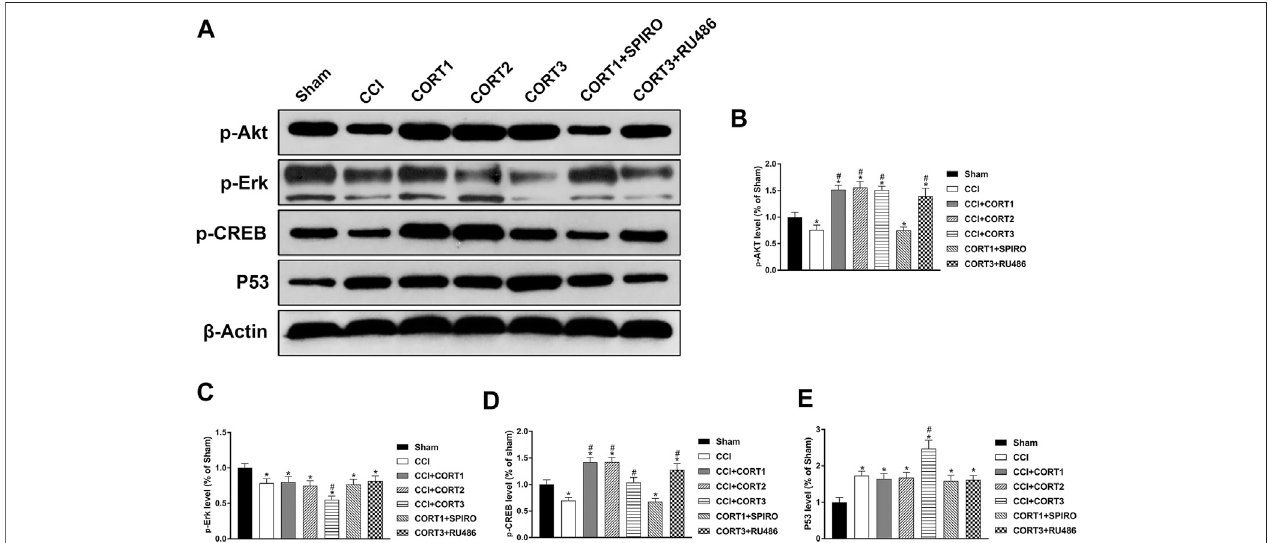
FIGURE 8 | Dose-dependent effects of CORT treatments on apoptosis were mediated by different signaling pathways. (A) Representative western blot images showing the levels of p -Akt, p -Erk, p -CREB, and P53. (B – E) Quanti fi cation of p -Akt, p -Erk, p -CREB, and P53 in the ipsilateral hippocampus on postinjury day 3. The relative band density was measured with ImageJ software (version 1.49) and normalized to that of β -actin, and the concentration percentage compared to that of sham controls was calculated for each sample. * p < 0.05 compared to the sham group; # p < 0.05 compared to the CCI control group. The data are presented as the mean ± SD of eight animals in each